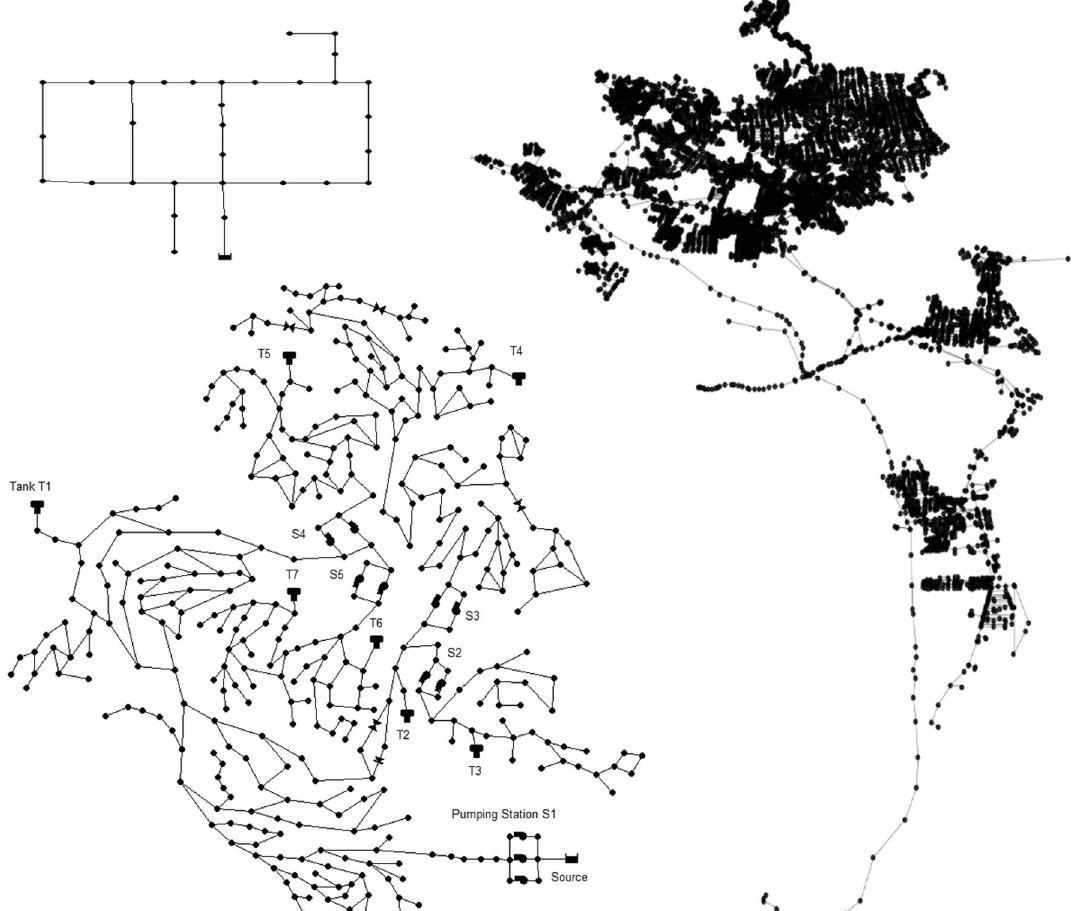
Fig. 2 Water distribution networks of Hanoi (upper left), C-town (lower left), and E-town